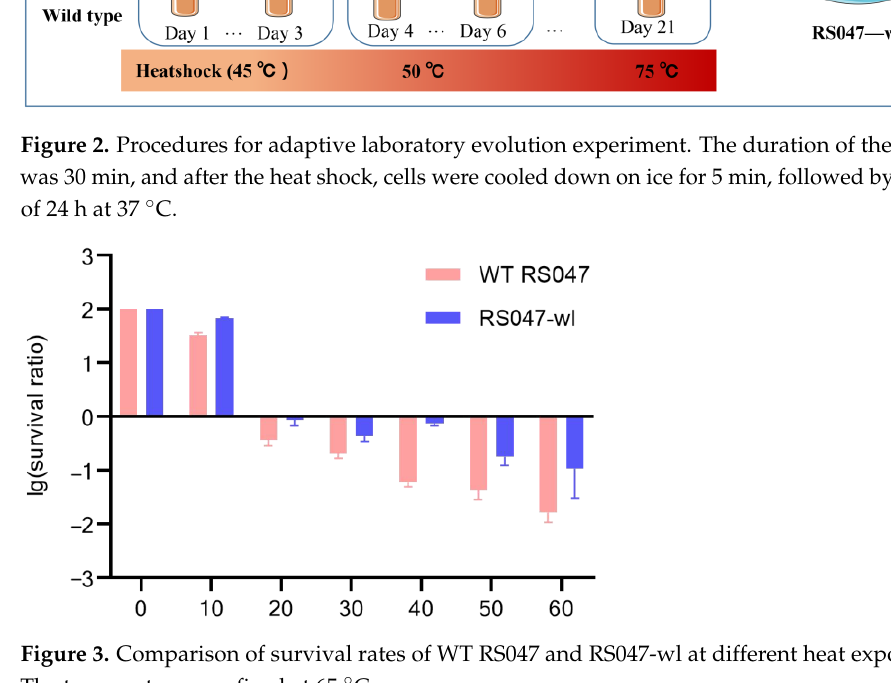
Figure 3. Comparison of survival rates of WT RS047 and RS047-wl at different heat exposure times. The temperature was fixed at 65 °C.